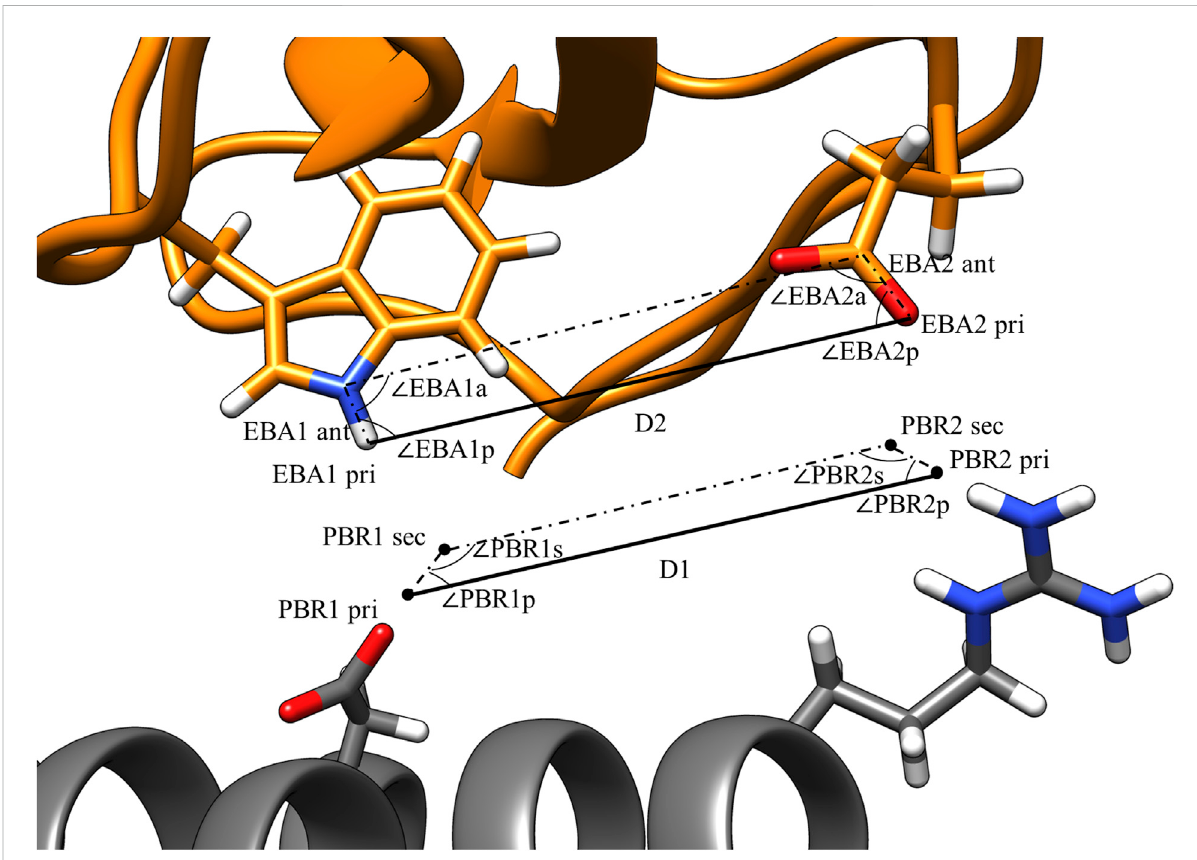
FIGURE 3 PBR and EBA pairwisedistance and angle calculations. PBRs generated for paratope ASP and ARG. EBA identi fi ed for epitope TRP and GLU. The interactionsbeingconsideredhereareH-bondsbetween1)ASPandTRPand2)ARGandGLU.Forthetwointeractionstobecompatible,|D1 – D2|